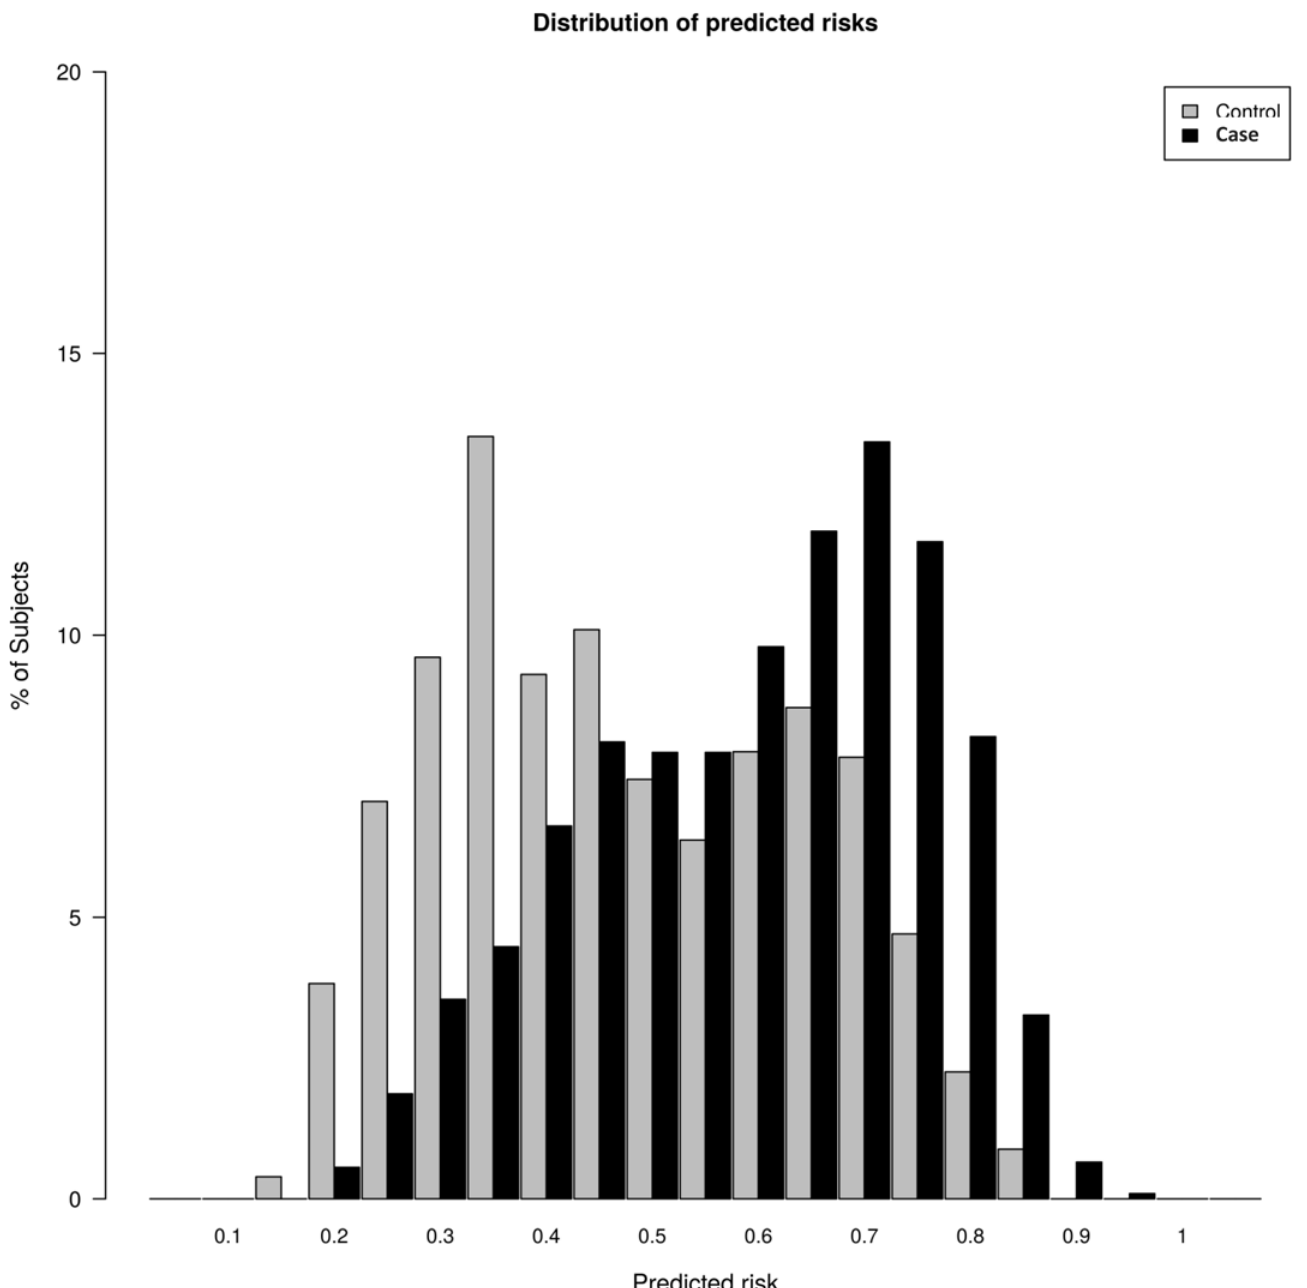
Fig 2. Distributions of predicted risks in cases and controls. The median of risk score was 0.60 (95% CI 0.59 – 0.61) for cases and 0.43 (95% CI 0.42 – 0.45) for controls. Risk score was significantly higher in advanced adenomas and/or